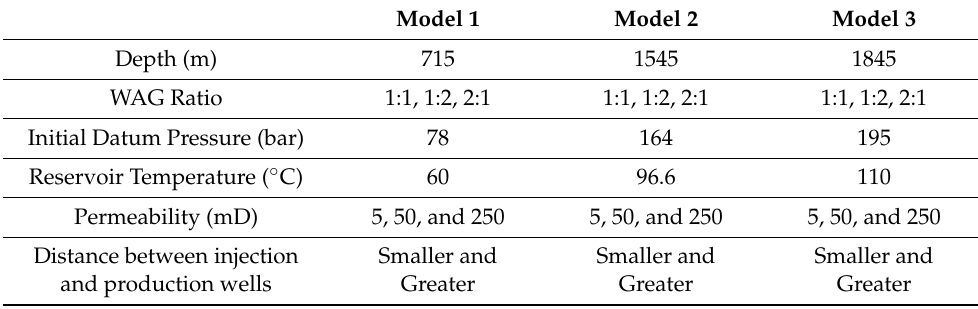
Table 1. Parameter matrix for numerical simulation case-sensitivity